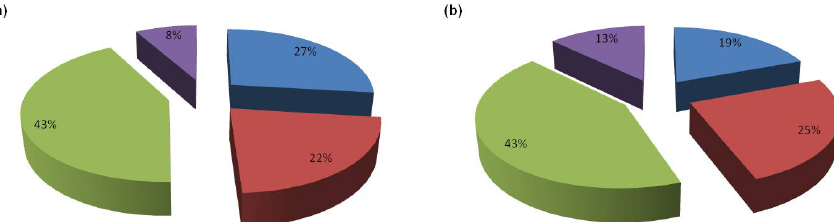
Fig. 4. Percentage of requests received during the first ten days (blue), from the first ten days to the first month (red), from the first month until six months (green) and from the sixth month until the first year (violet): (a) in Catalonia and (b) in the Balearic